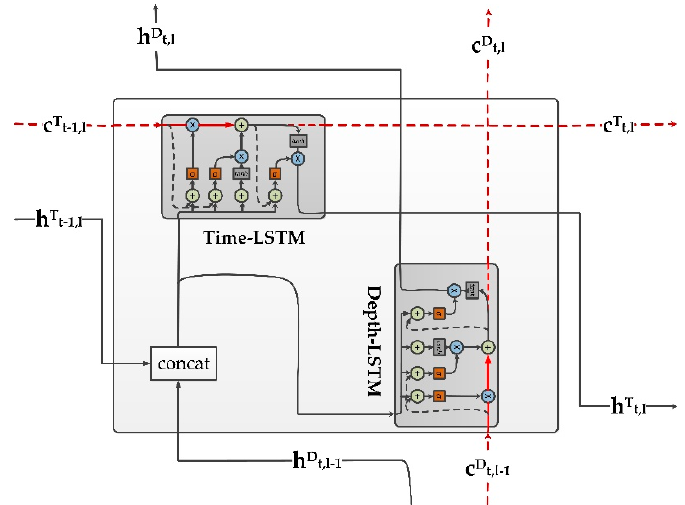
Figure 2. GridLSTM (GridLSTM) blocks. A GridLSTM block contains two LSTM blocks in different dimensions. Time-LSTM denotes the LSTM in the time dimension; Depth-LSTM denotes the LSTM block in the depth dimension.